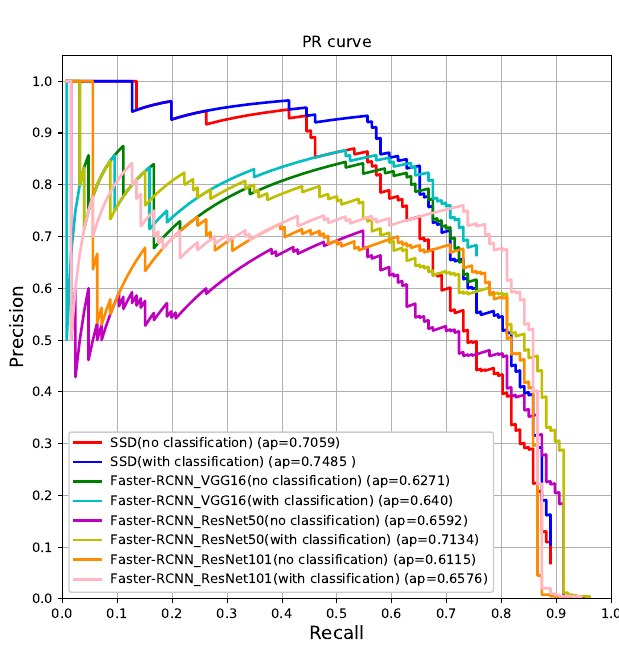
Figure 8. Target detection algorithm PR (Precision-Recall) curve. (1) In the figure, each target detection algorithm draws two PR curves. One is a PR curve that is directly input with 753 sheets as an algorithm without going through the classification process. The other is the PR curve drawn with 334 images as the algorithm input. (2) After using the two stages framework, each algorithm has a different degree of increase in the AP value, which is since the first stage classifier filters out 60% of the negative samples. (3) The SSD has the highest 0.7485 AP value, while the Faster-RCNN (with VGG16) AP is the lowest 0.64 of all